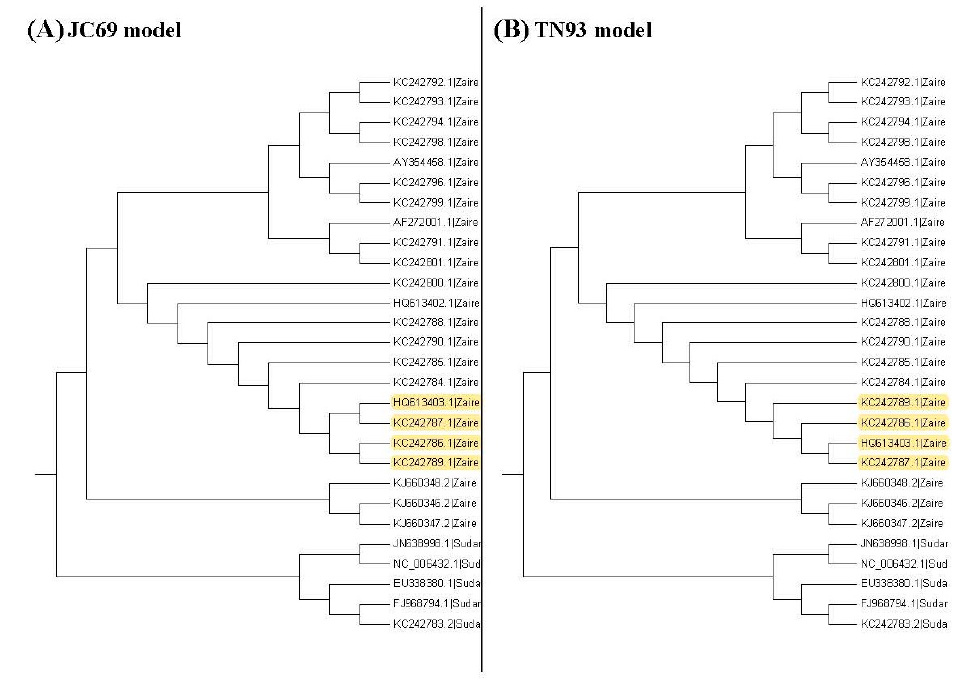
Figure 5. The UPGMA trees for the Ebolavirus sequences. Yellow color: difference.